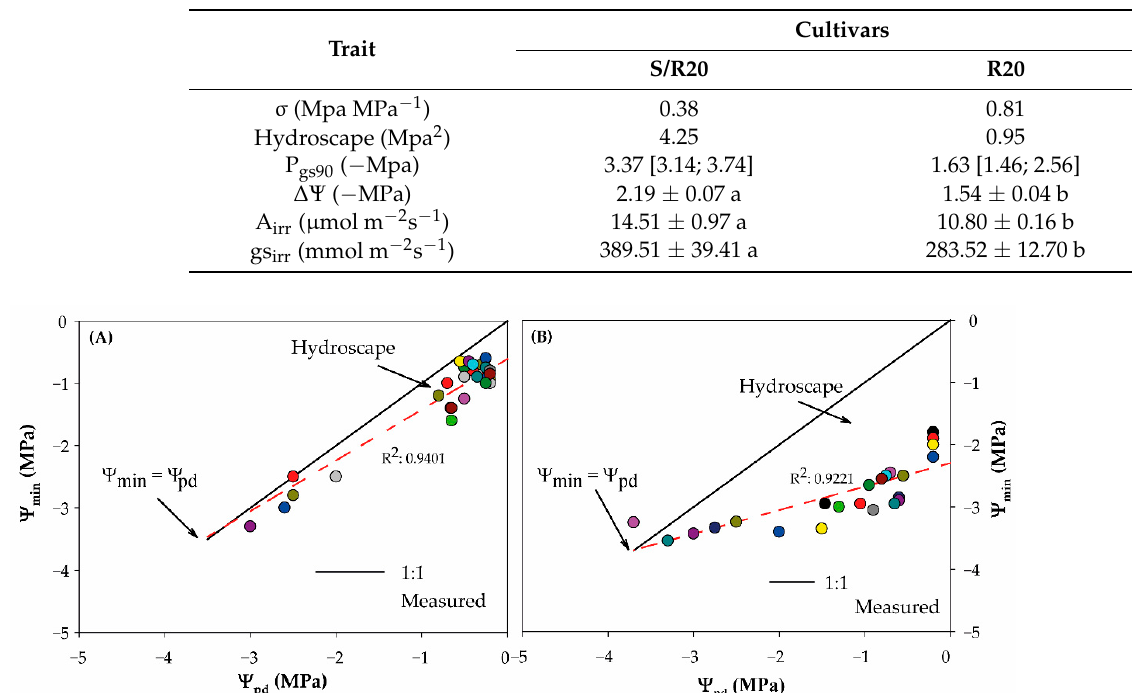
Figure 2. Relationship between pre-dawn water potential ( Ψ pd ) and midday water potential ( Ψ min ) for the R20 ( A ) and S/R20 ( B ) Prunus dulcis cultivars. Continuous black lines represent a 1:1 line when Ψ pd = Ψ min , and the dashed line represents a fitted linear regression for Ψ pd vs. Ψ min . Symbols in colors represent measured values of individual plants during the SD experiments. Table 2. Mean (± standard error) values of leaf photosynthetic traits measured at the end of the SD experiments, sources of variation, and p- values of Prunus cultivars subjected to substrate desiccation. V cmax : maximum rate of Rubisco carboxy- lation, J: electron transport rate, g m : mesophyll conductance to CO 2 . Different letters indicate statistical differences among means ( p ≤ 0.05).